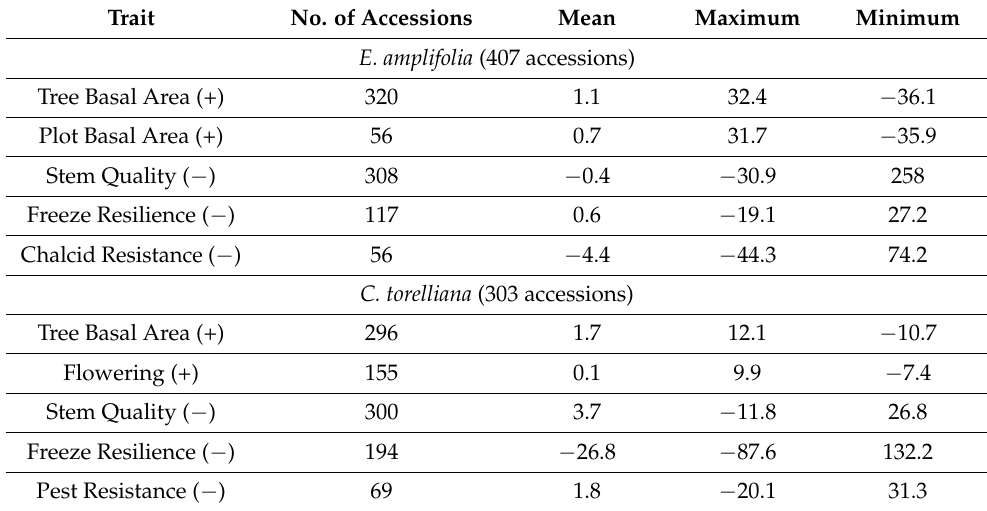
Table 3. Number of accessions assessed and mean, maximum, and minimum breeding values (%, + or – indicates best, where % indicates positive or negative percentage deviation from the checklot least square mean) for Eucalyptus amplifolia and Corymbia torelliana by trait.